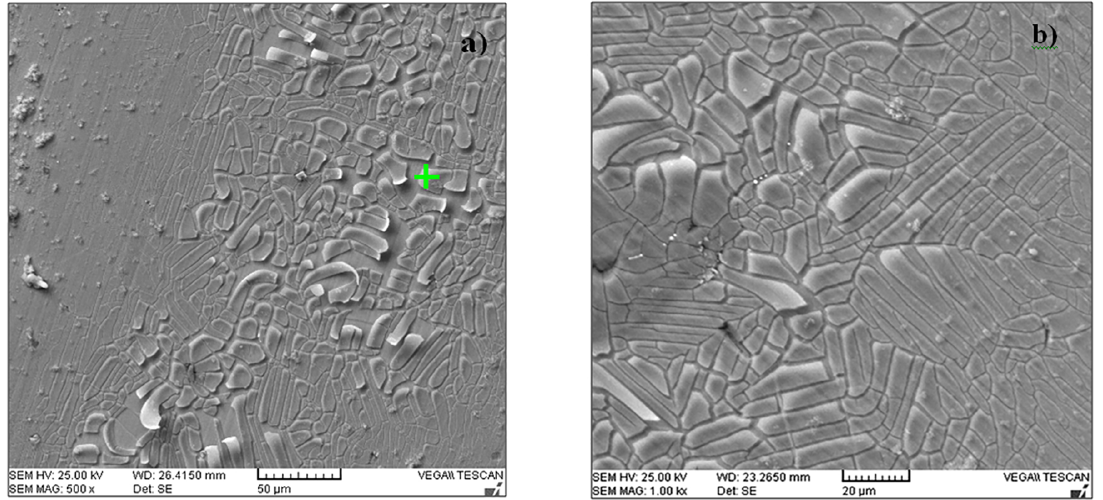
Figure 12. SEM of the 20% manganese steel corrosion products in aqueous solution 0.1M NaCl. Source: author